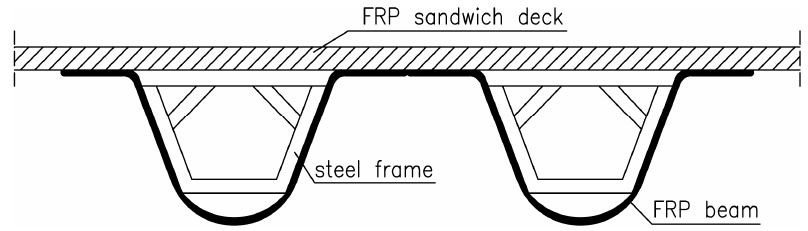
Figure 8. Schematic of an Ineel deck using composite beams with a box cross-section [51].